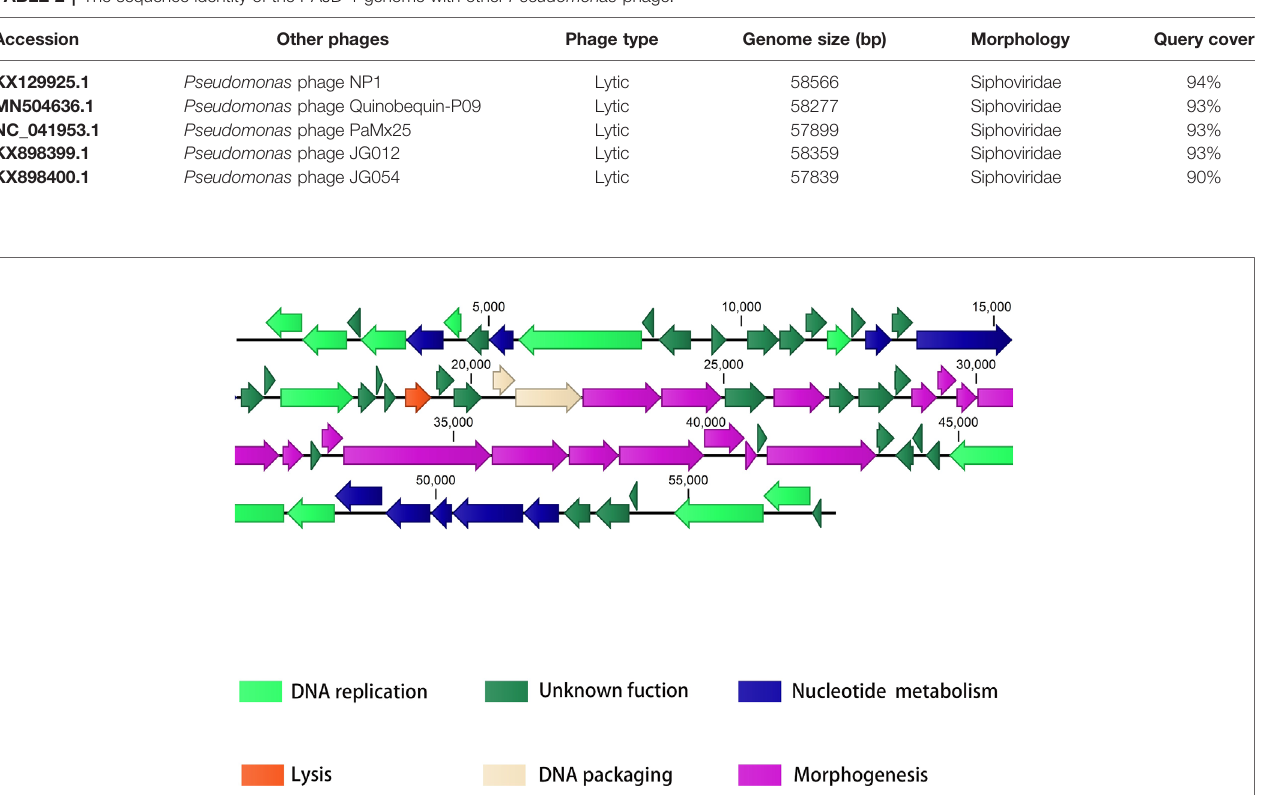
TABLE 2 | The sequence identity of the PAJD-1 genome with other Pseudomonas phage.